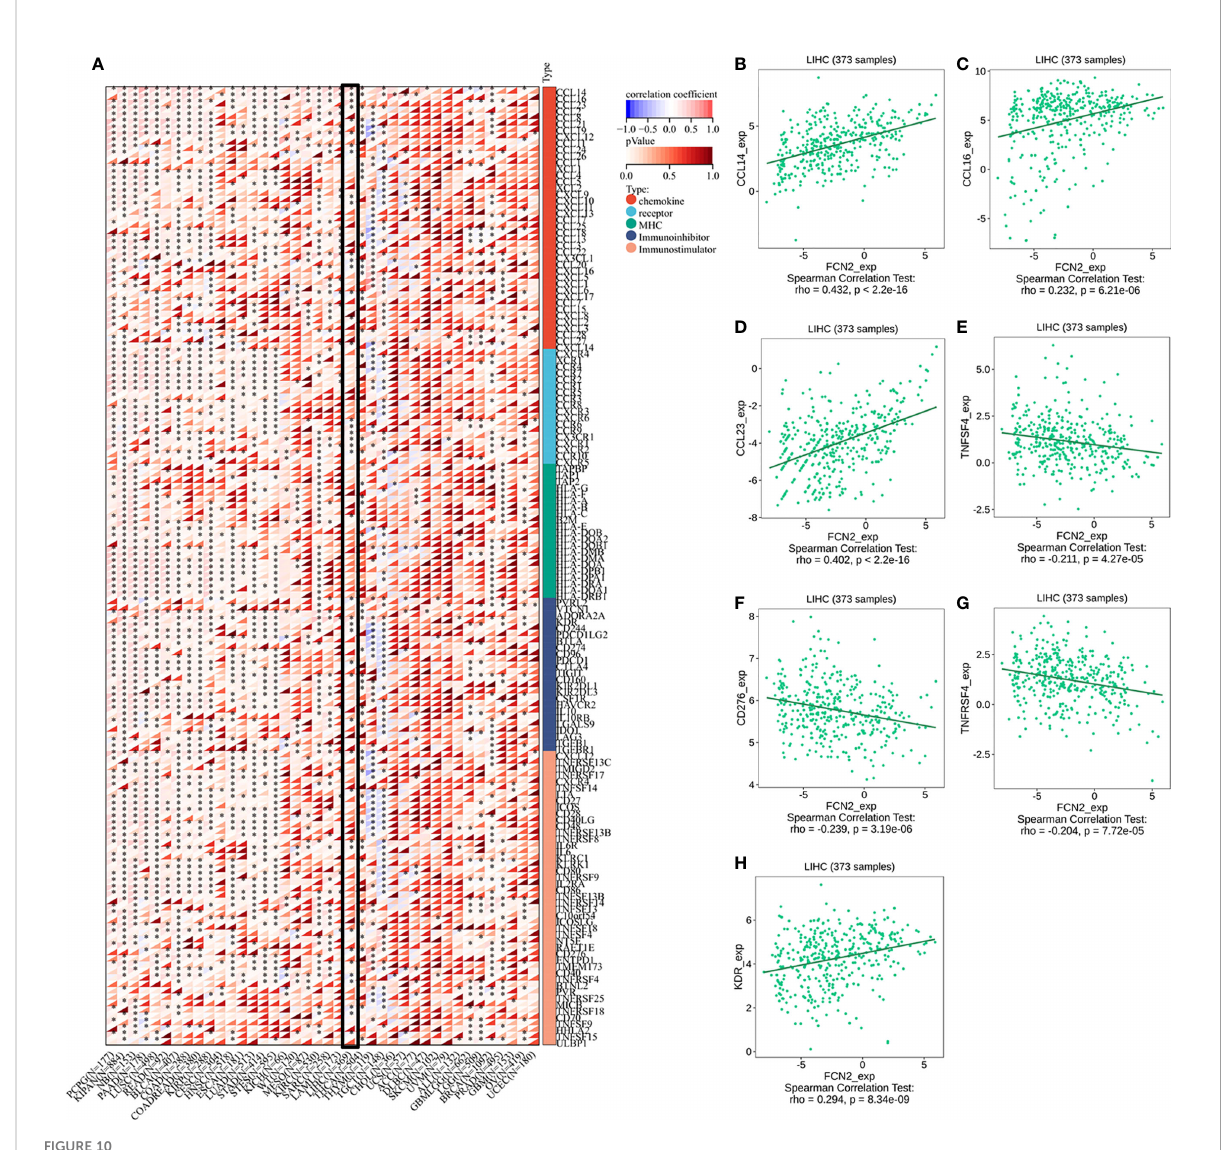
FIGURE 10 Immunomodulators, chemokines, and receptors associated with FCN2 . (A) Distribution of the FCN2 immunological scores in tumor and normal tissues.The ordinate re fl ects the distribution of the immunological scores in distinct groups, whereas the abscissa indicates the immune cell types. The Wilcoxon test was used to compare statistical differences between the two groups, and the Kruskal – Wallis test was used to determine the signi fi cance of the differences between three groups. ( a ) Heatmap of the immune cell scores. Different hues represent the varied expression distributions in different samples. Asterisks indicate signi fi cance levels at * p < 0.05, ** p < 0.01, and *** p < 0.001. ( b ) Percentages of tumor-in fi ltrating immune cells in each sample. Different colors depict the different types of immunological cells. The abscissa denotes the sample, whereas the ordinate denotes the percentage of immune cells in a single sample. (H) Immunomodulators, chemokines, and receptors associated with FCN2 in liver hepatocellular carcinoma (LIHC). (B) CCL14. (C) CCL16. (D) CCL23. (E) TNFSF4. (F) CD276. (G) TNFRSF4. (H) KDR. **** p <